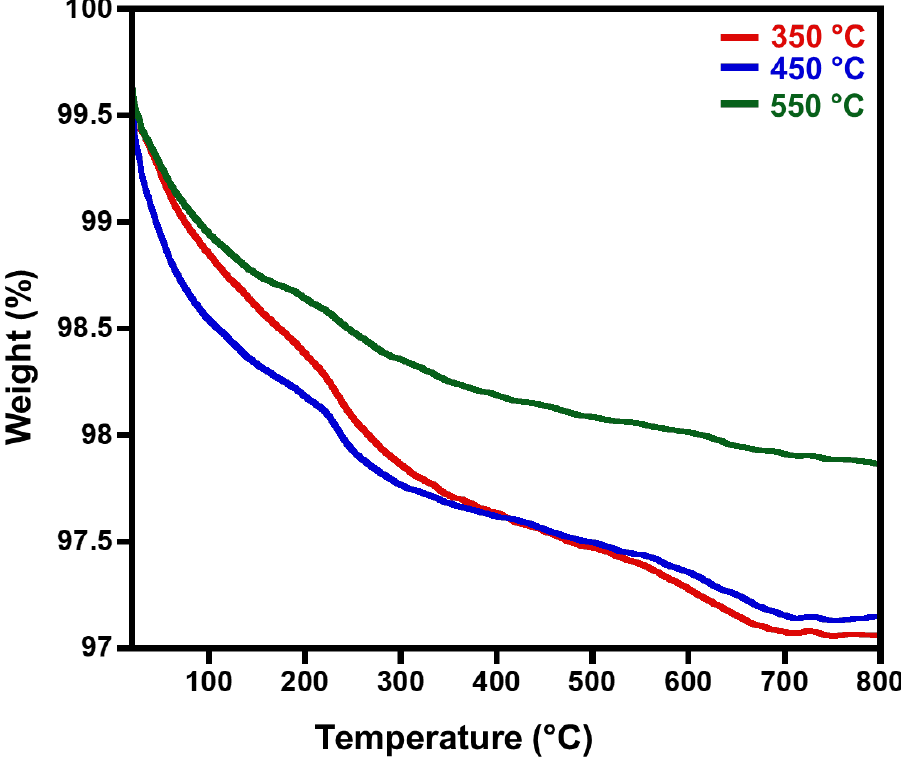
Figure 3. TGA analysis of Cu x Zn y O mixed metal oxide nanoparticles calcined at 350, 450, and 550 °C.